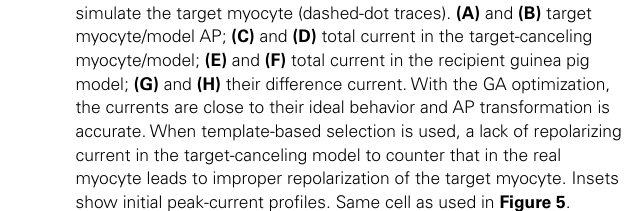
FIGURE 9 | In silico and in vitro CTC circuit currents. Left panels show APs and related currents in CTC for an experiment using a GA-optimized target-canceling model (solid traces) as well as the corresponding ideal case of simulating that optimized model as both the myocyte and its canceling model (dashed traces). Right panels compare CTC-on APs and currents for an experiment using template-based model selection for the target-canceling model (solid traces) to an in silico case of mismatch between that same template-based target-canceling model and a GA-optimized model to